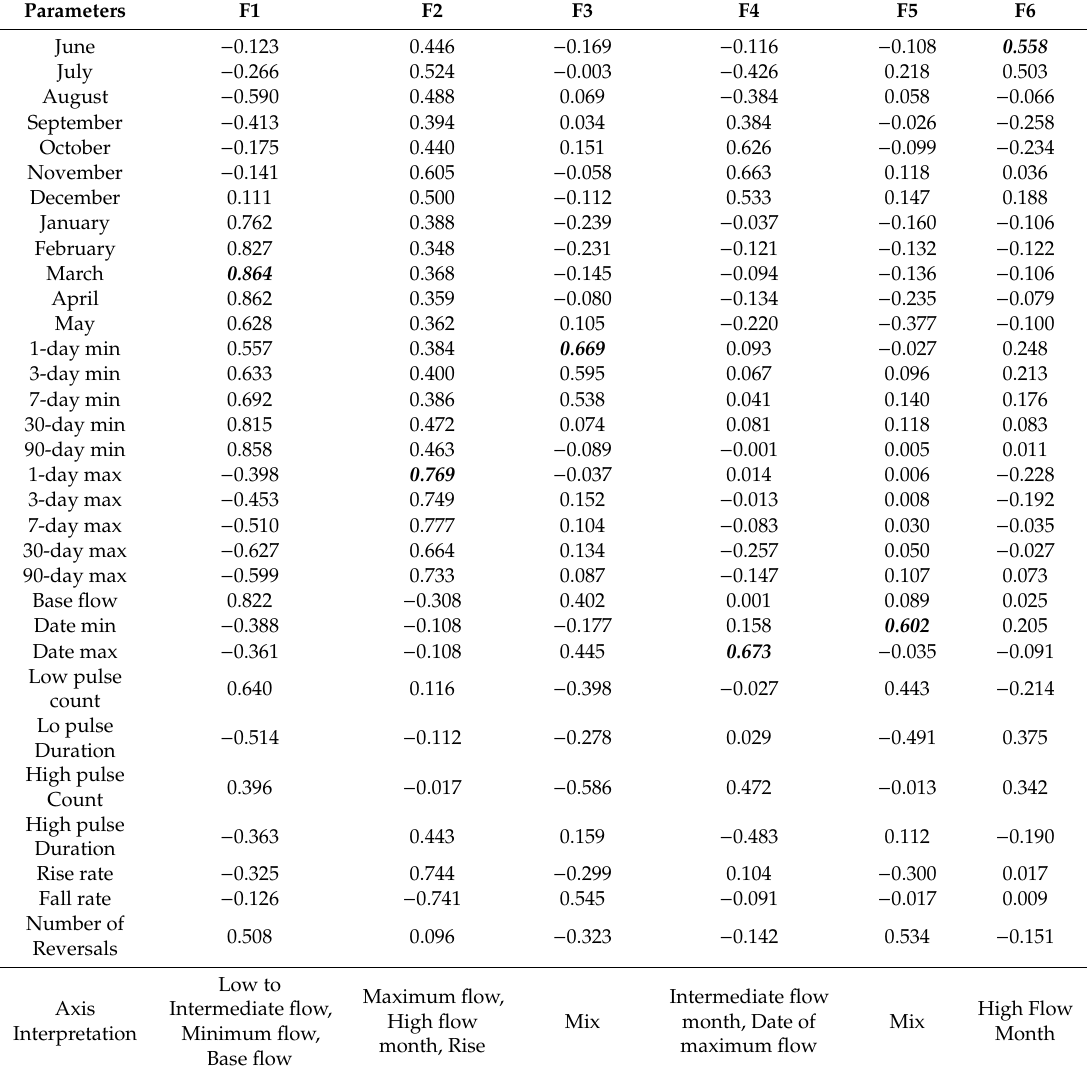
Table 3. Loadings for first Six PCs in the Pearson